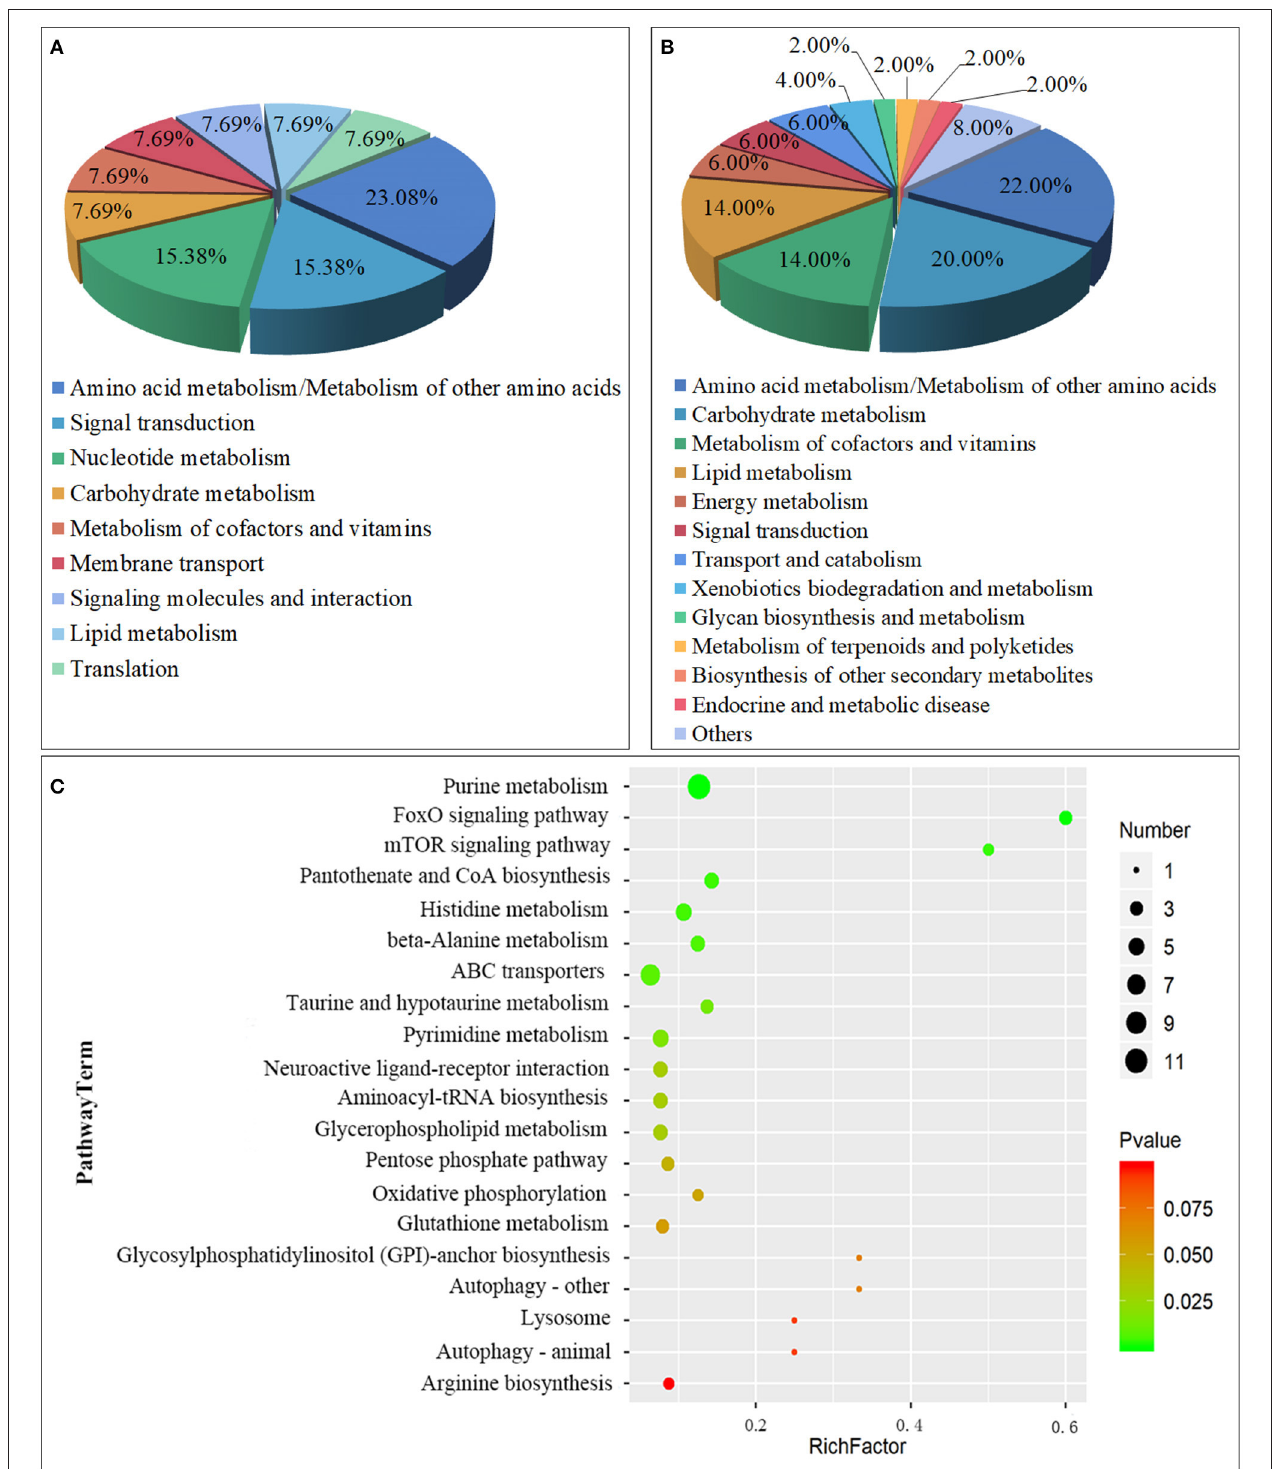
FIGURE 5 | Class of Metabolic pathway pie chart in the gill tissues of the S.paramamosain adapting to low salinity: significant enrichment (A) and non-significant enrichment (B) ; The metabolome view map of top 20 metabolic pathways in gills for S.paramamosain adapting to low salinity (C) .